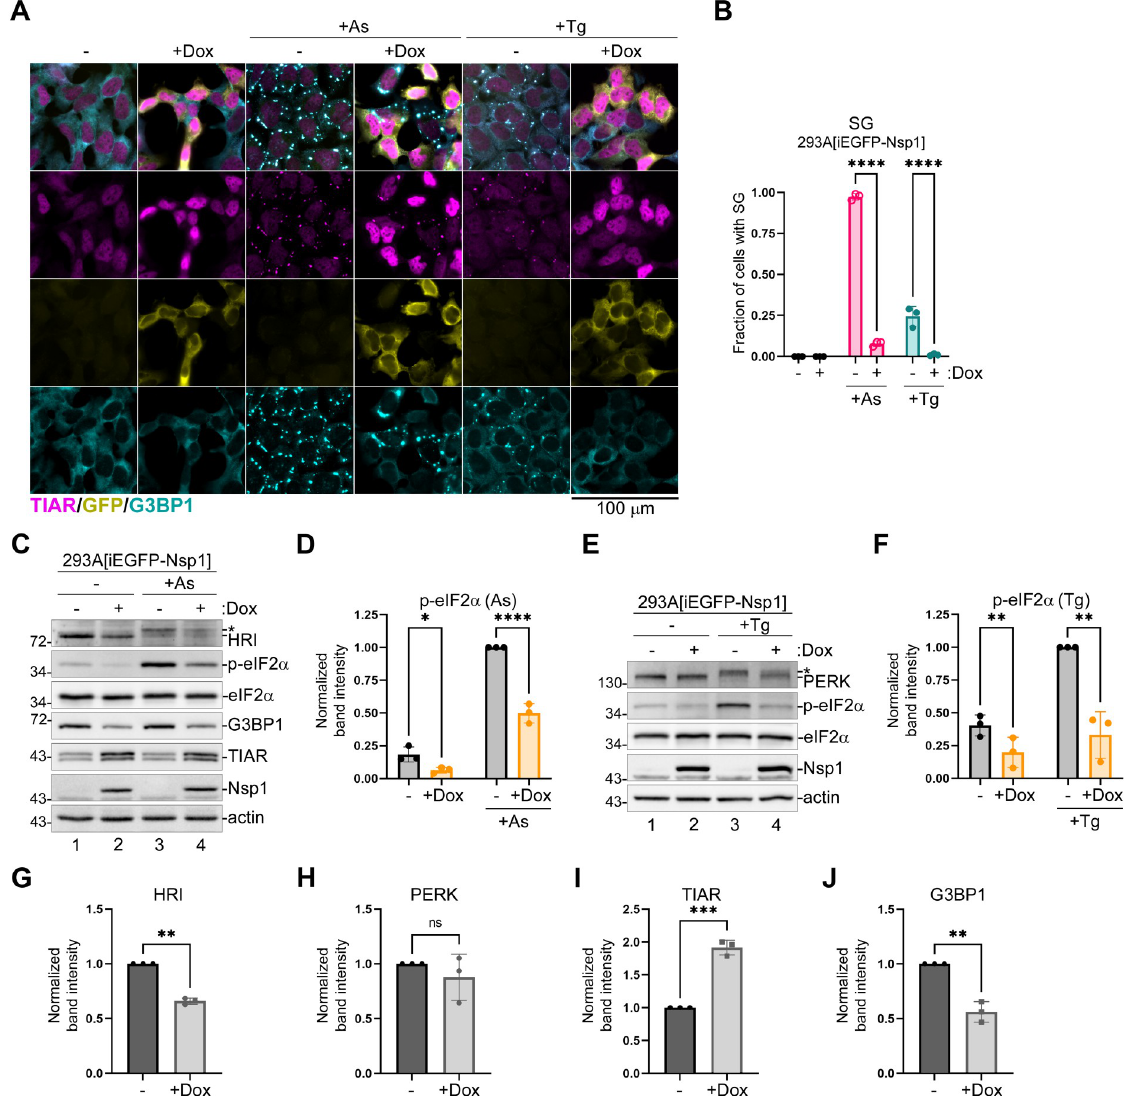
Fig 6. CoV2 Nsp1 downregulates HRI and inhibits PERK activation. Expression of EGFP-tagged CoV2 Nsp1 was induced in 293A [iEGFP-Nsp1] cells by treatment with doxycycline (+ Dox) for 24 h and induced and uninduced control cells (-) were treated for 50 min with 500 μ M sodium arsenite (+As) or 1 h with 1 μ M Thapsigargin (+Tg) where indicated. (A) Immunofluorescence microscopy analysis of SG induction using staining for TIAR (magenta) and G3BP1 (teal). GFP signal from EGFP-Nsp1 fusion protein is shown in yellow. Scale bar = 100 μ m. (B) SG formation was quantified from microscopy analyses represented in A. (C) Western blot analysis of lysates from control and As-treated cells. (D) Phospho-eIF2 α band intensity normalized to total eIF2 α was quantified from C and plotted relative to phospho- eIF2 α level in uninduced control cells treated with As. (E) Western blot analysis of lysates from control and Tg-treated cells. (F) Phospho- eIF2 α band intensity normalized to total eIF2 α was quantified from E and plotted relative to phospho-eIF2 α level in uninduced control cells treated with Tg. (G-J) Relative band intensities of HRI (G), PERK (H), TIAR (I), and G3BP1 (J) normalized to actin were quantified from C and E. Values for untreated Dox-induced cells were plotted relative to uninduced cells. On all graphs each data point represents independent biological replicate (N = 3). Error bars = standard deviation. Two-way ANOVA and Tukey multiple comparisons tests were performed in D and E and unpaired two-tailed Student’s t-Test in G-J to determine statistical significance ( ���� , p -value < 0.0001; ��� , p -value < 0.001; �� , p-value < 0.01; � , p-value < 0.05; ns, non-significant).